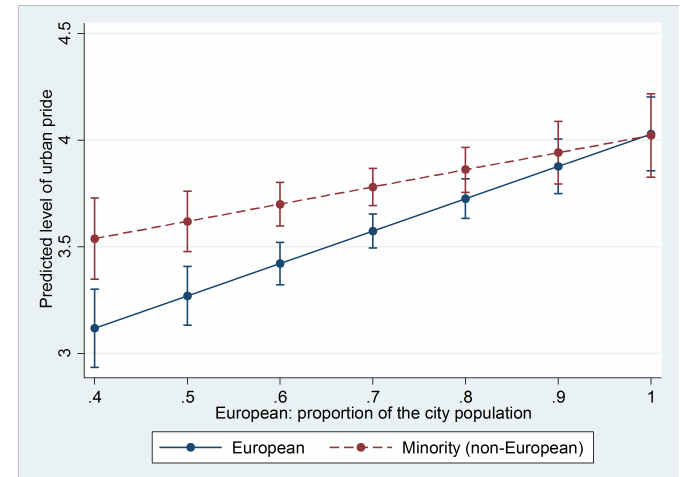
Figure 5: The positive impact of minority status on urban pride falls as the proportion of Europeans in the city rises. New Zealand,